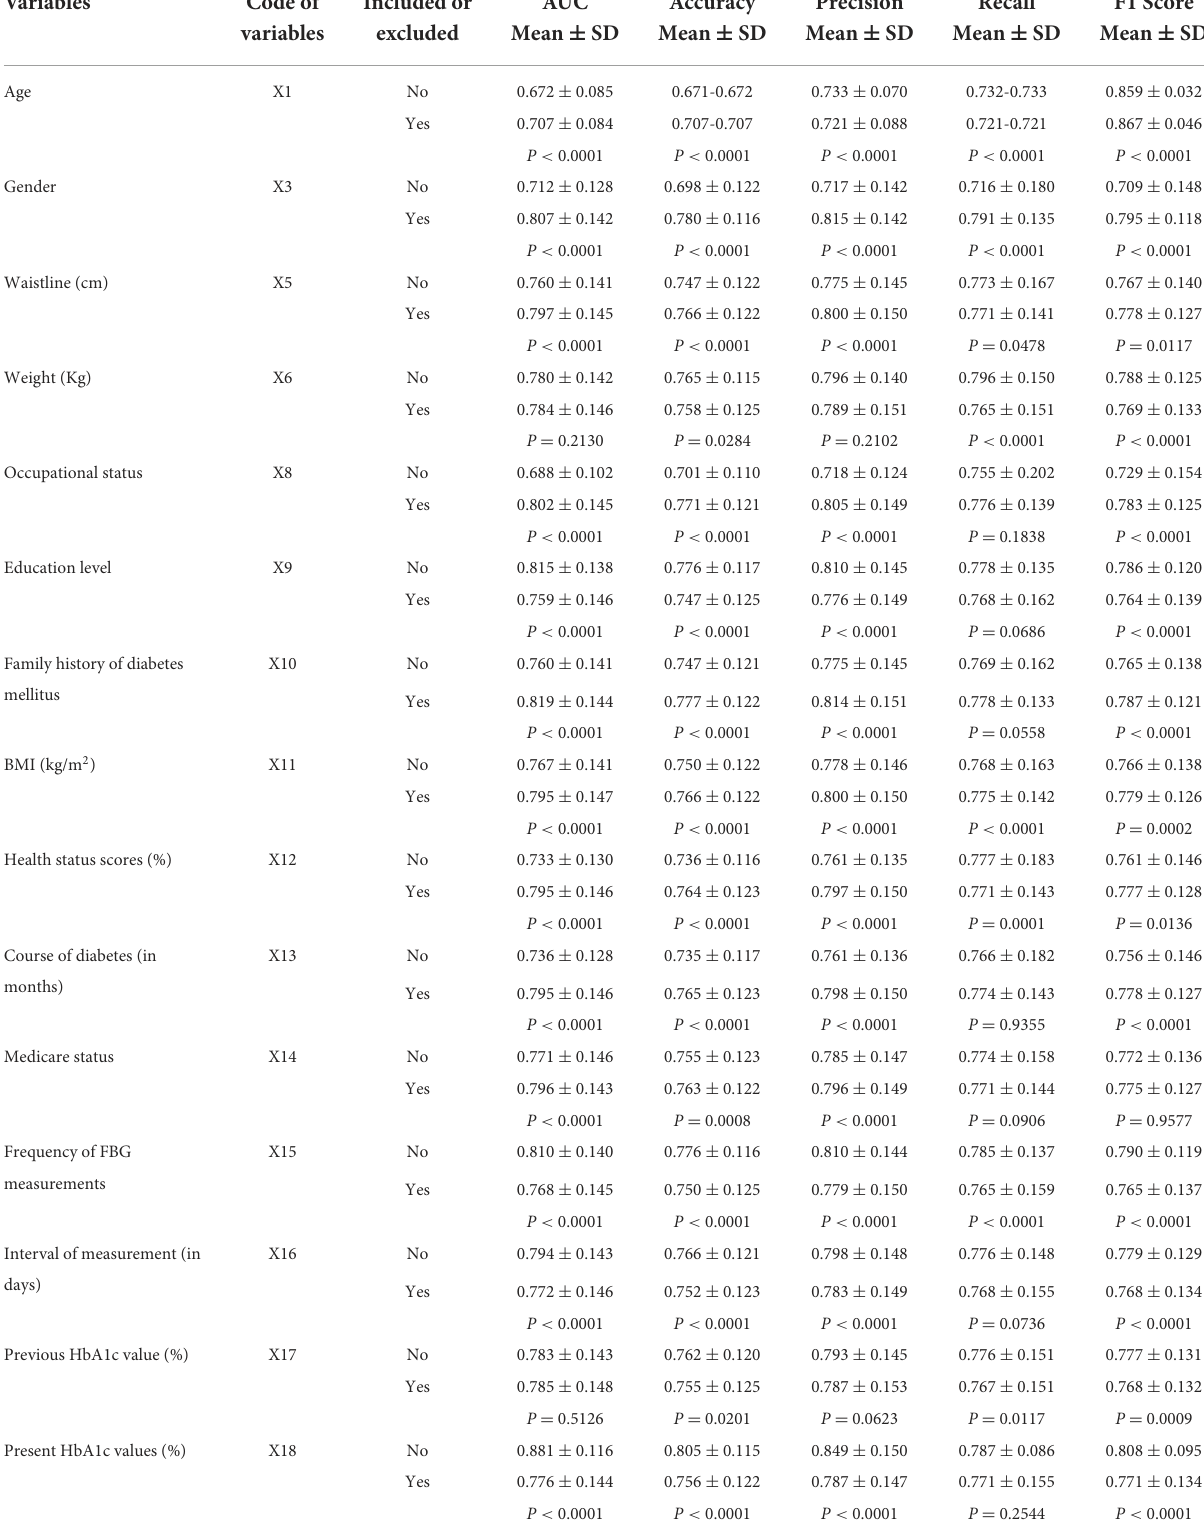
TABLE 5 The influence of model performances whether the variable was included or